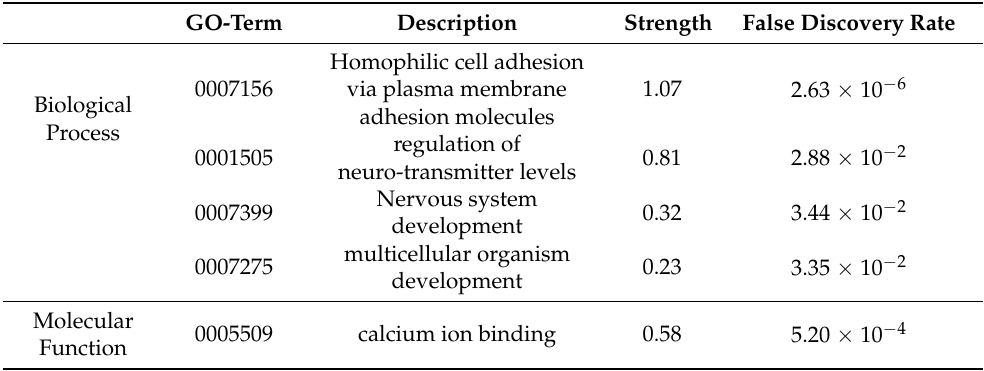
Table 3. The GO enrichment results of differentially methylated genes related to aging (based on differentially methylated probes).